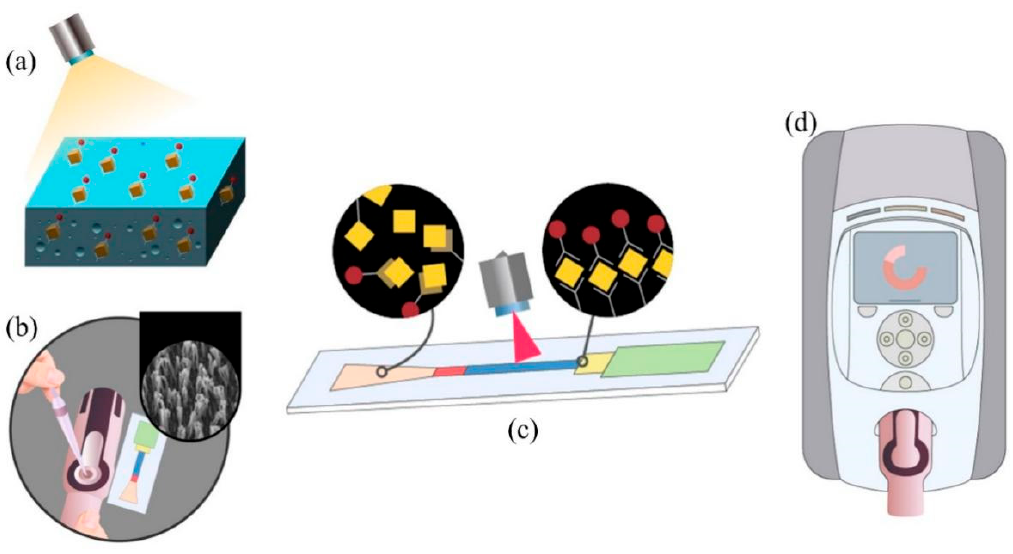
Figure 1. Illustration of the overall experimental strategy. ( a ) The principle of NC membrane action in conventional immunochromatographic test strips. Only the surface signal of the membrane can be measured. ( b ) A microfluidic chip based on nanoforest structure was designed for the detection of AT and RT. ( c ) Progress of the sample reaction. ( d ) The fluorescence signal value can be read after 15